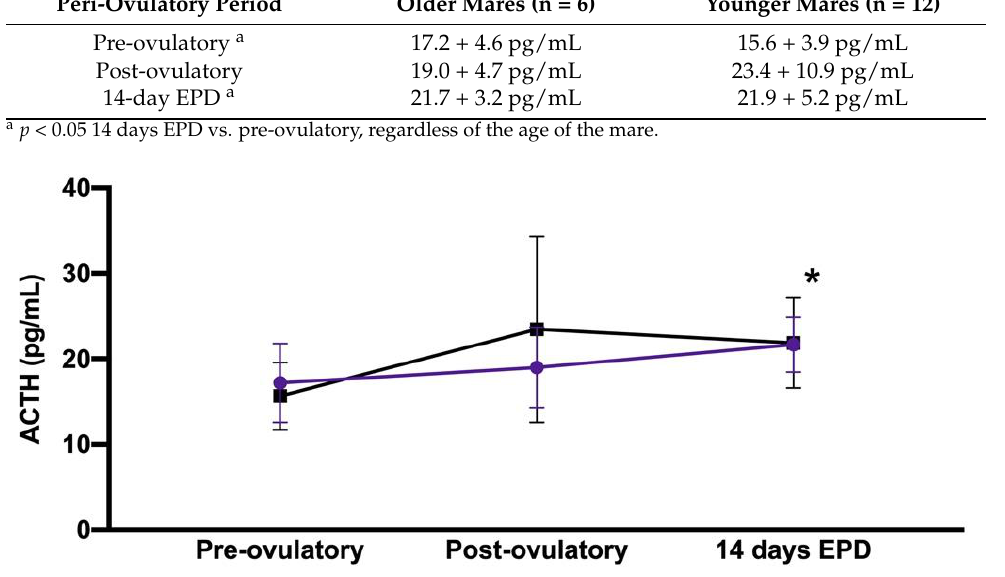
Table 2. Mean ± standard deviation in immunoreactive plasma adrenocorticotropic hormone (ACTH) concentrations associated with age and peri-ovulatory period. (EPD: early pregnancy diagnosis).